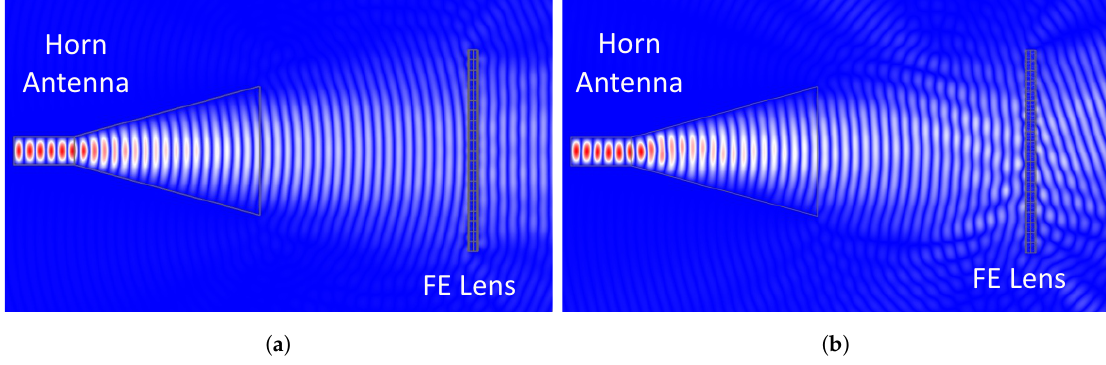
Figure 7. Wave electric field distribution in case of ( a ) the beam focusing and ( b ) the beam scanning.